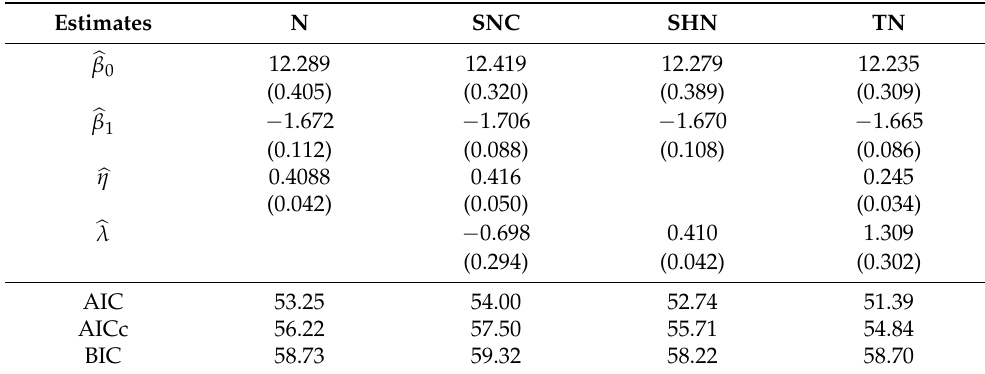
Table 5. MLE for the biaxial fatigue data and the corresponding standard errors (in parenthesis), AIC, AICc, and BIC values.